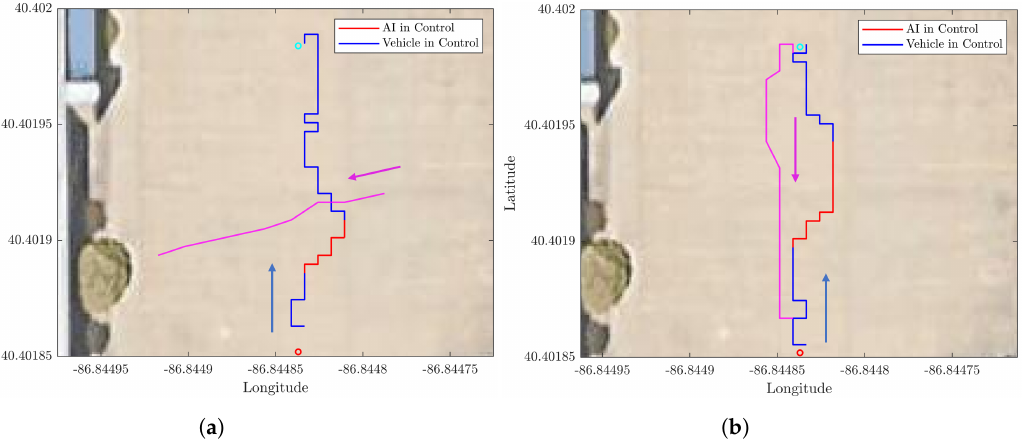
Figure 11. Real-world UGV obstacle avoidance experiment. ( a ) Cross scenario. ( b ) Head-on scenario. The trajectory has a mean cross-track error of 0.92 with respect to obstacle size. The ob- stacle size is the average person’s stride length of 0.7 m. The trajectory plots show that the UGV is able to navigate through an environment with dynamic obstacles without collision and find a path to its